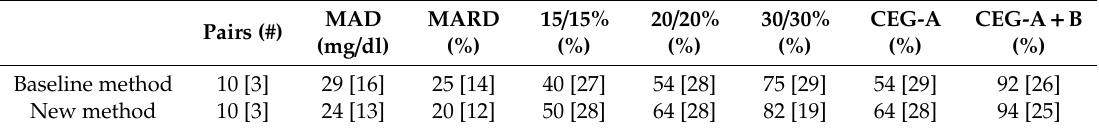
Table 2. Performance metrics as median [interquartile range] or mean (standard deviation).